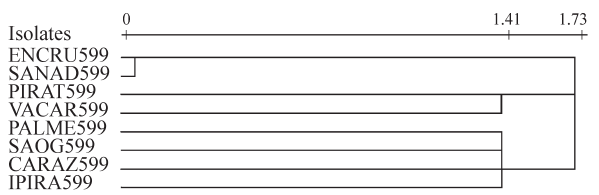
Figure 4 - Dendrogram of the relationships between Drechslera teres iso- lates based on colony morphology (edge, texture, color and sector).